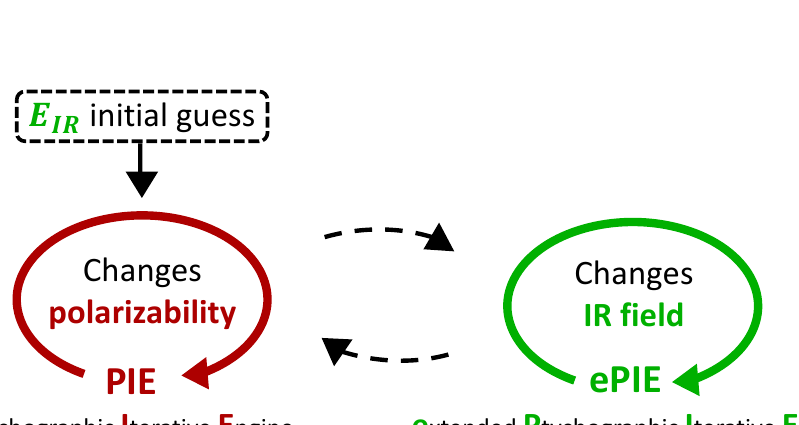
Figure 1. Scheme of the reconstruction algorithm. The reconstruction takes place in two steps: in the first stage (PIE), the algorithm updates the complex polarizability γ + i α ; in the second stage (ePIE), the polarizability is kept constant, and the IR field is modified. 2 Both PIE and ePIE update the dipole O ( t ), associated to the exciton dynamics.